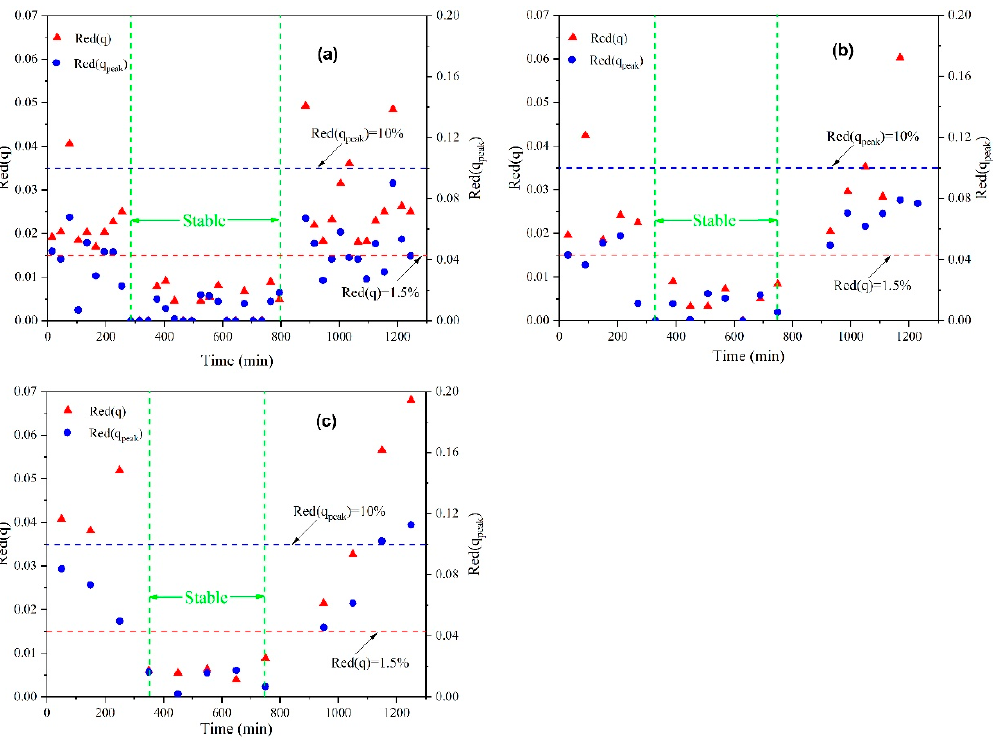
Figure 6. The determination of stable power input with different segmented time-sections of 30 min ( a ), 60 min ( b ), and 100 min ( c ).